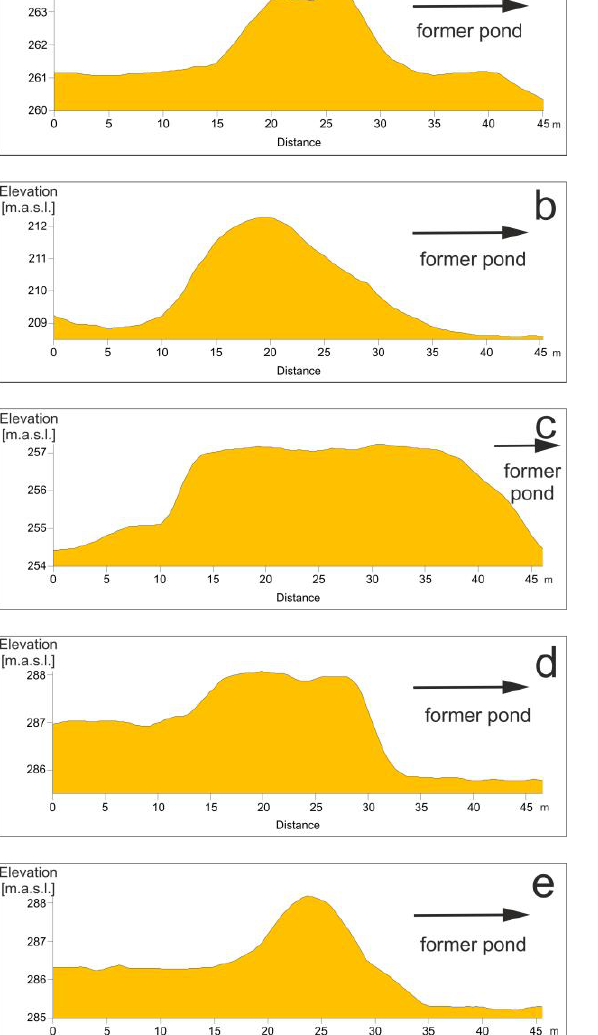
Fig. 11. Location of the former ironworks near the town of Kalety on the shaded relief map with cross section lines representing valley relief indicated Fig. 12. Cross sections of the main weir in the former ironworks selected: a – Bobrza; b – Regolowiec; c –